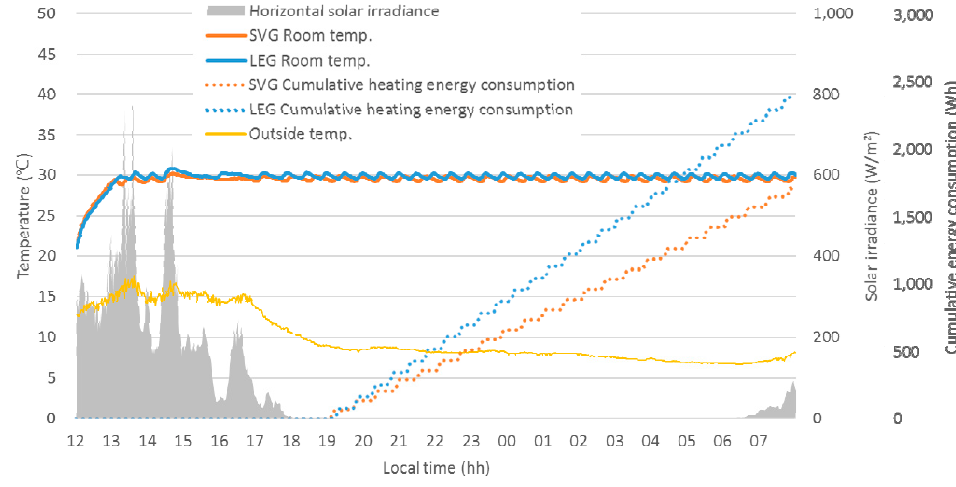
Figure 5. Temperature distribution and energy consumption of the SVG and LEG (1–2 April 2017).